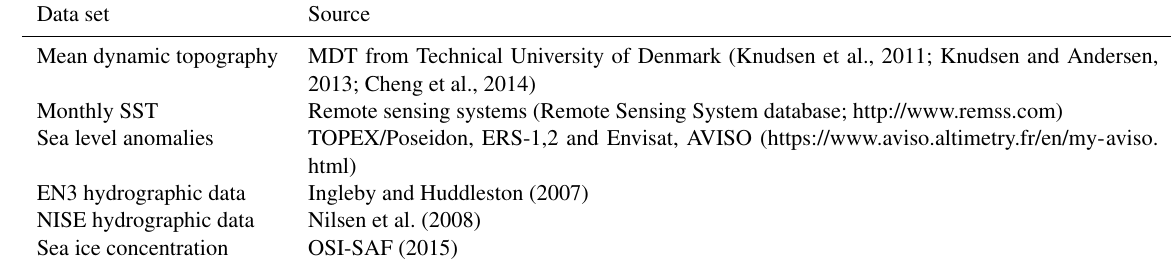
Table 1. Data sets used in the assimilation